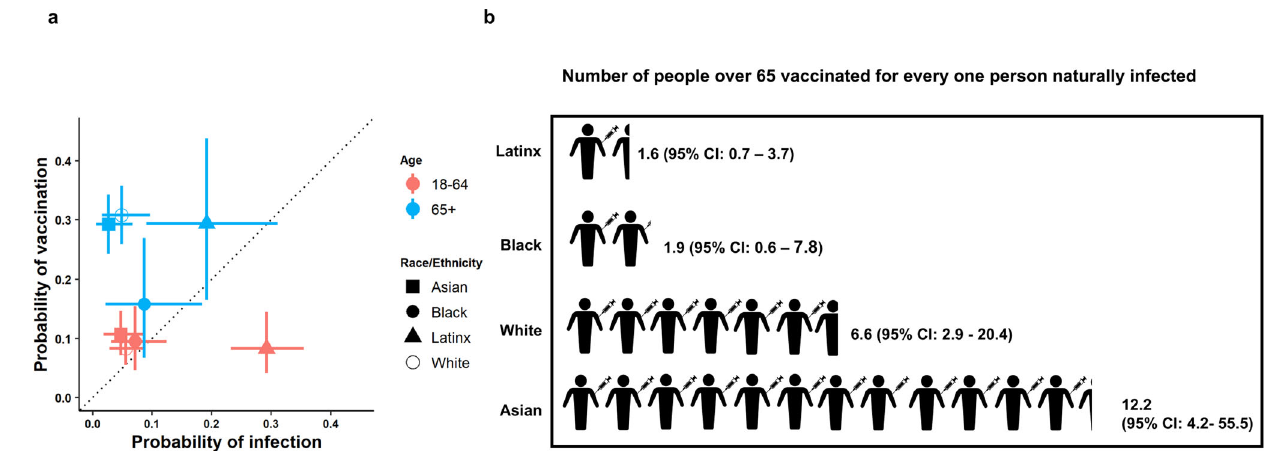
Fig. 5 Relationship between probability of vaccination and probability of prior infection by race/ethnicity. a Probability of infection vs. probability of vaccination by age and race/ethnicity. Error bars show the upper and lower limits of the 95% Credible Interval of the estimates, and points show the median of the estimates. (65 + and Black/African American, N = 33; 65 + and White, N = 160; 65 + and Hispanic/Latinx, N = 37; 18 – 64 and Black/African American, N = 82; 18 – 64 and White, N = 202; 18 – 64 and Hispanic/Latinx, N = 130). b Infographic showing the number of estimated people vaccinated for every one person previously naturally infected in San Francisco within each racial/demographic group.